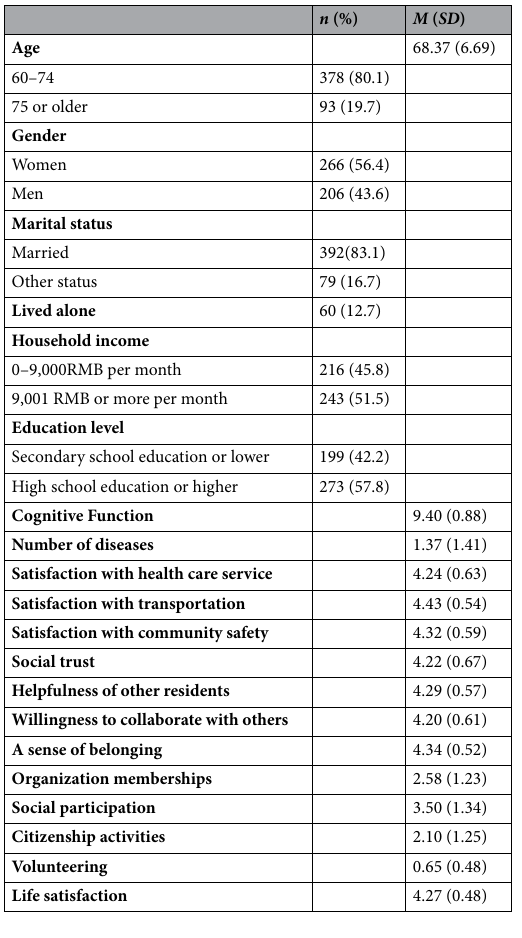
Table 1. Sample characteristics ( N = 472). 100 RMB = $15.52 USD.